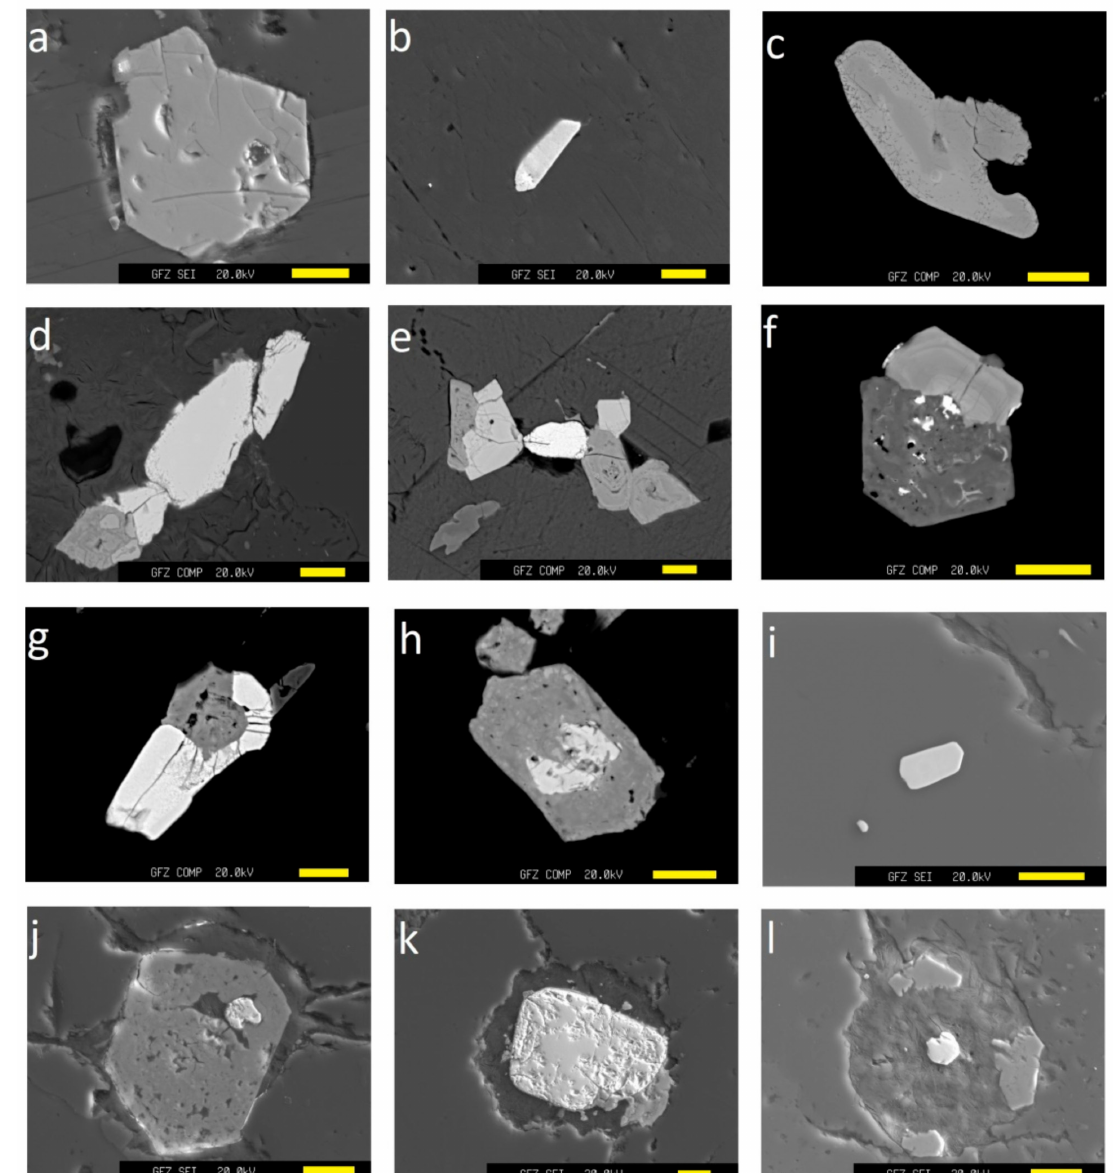
Figure 3. Back-scattered electron images of radioactive accessory minerals from Podles í : ( a ) a euhedral homogeneous crystal of monazite from the deeper part of the stock granite (#3436); ( b ) a columnar crystal of monazite inherited in mica in greisen (#3365); ( c ) a zoned monazite crystal with rims enriched in cheralite component, deeper stock granite (#3436); ( d ) three grains of monazite (white) associated with zircon (dark gray) and small grains of xenotime (light gray) from stockscheider (#3361); ( e ) monazite (white in the center) associated with two grains of xenotime (light gray) and three crystals of zircon (dark gray) inherited in mica, deeper stock granite (#3443); ( f ) a zoned xenotime crystal (light gray) growing on zircon (dark), deeper stock granite (#3436); ( g ) xenotime (light gray) covering a zircon grain (dark), lower stock granite (#3443); ( h ) xenotime (light) overgrown by zircon (dark), lower stock granite (#3436); ( i ) a uraninite crystal in quartz, stockscheider (#3361); ( j ) a uraninite grain in zircon, lower stock granite (#3436); ( k ) a uraninite crystal rimmed by a halo of radioactively damaged feldspar, lower stock granite (#3436); ( l ) a uraninite grain (white) in the center of a radioactively damaged halo in mica, three pyrite grains (dark gray) crystallized along the outer rim of the halo, lower stock granite (#3443). Scale bar = 10 µ